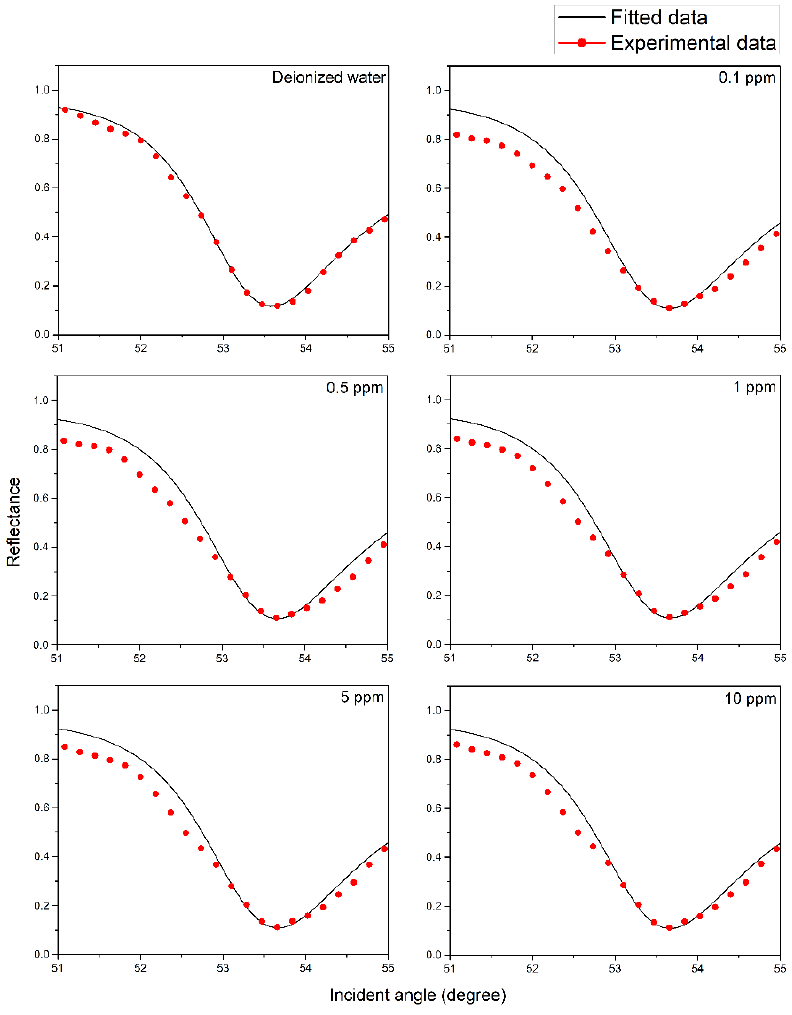
Figure 9. Fitted SPR signal of the gold thin film in contact with deionized water and copper